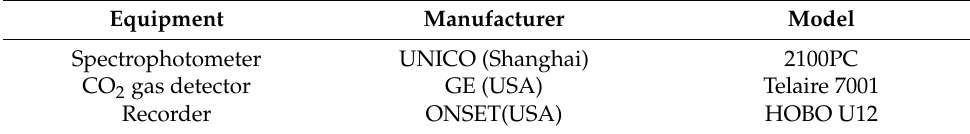
Figure 1. Test equipment: ( a ) spectrophotometer, ( b ) Telaire 7001 and HOBO. Table 3. Equipment